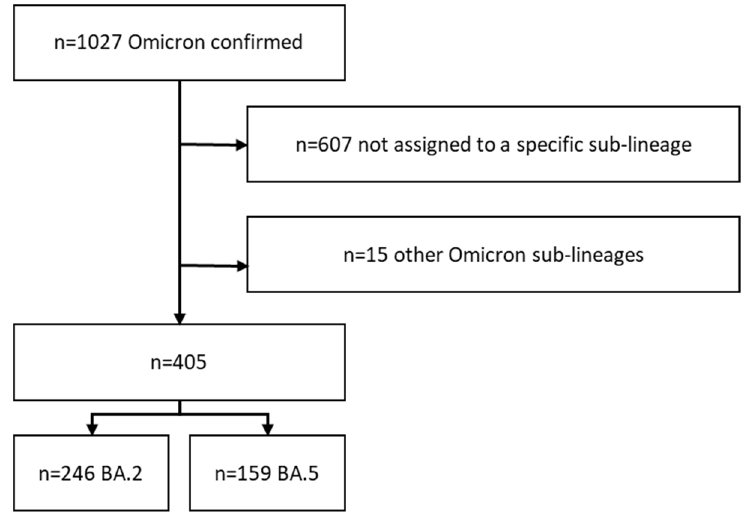
Figure 1. Sample size of the study population. In total, 405 assigned BA.2 and BA.5 cases were included in the analyses.